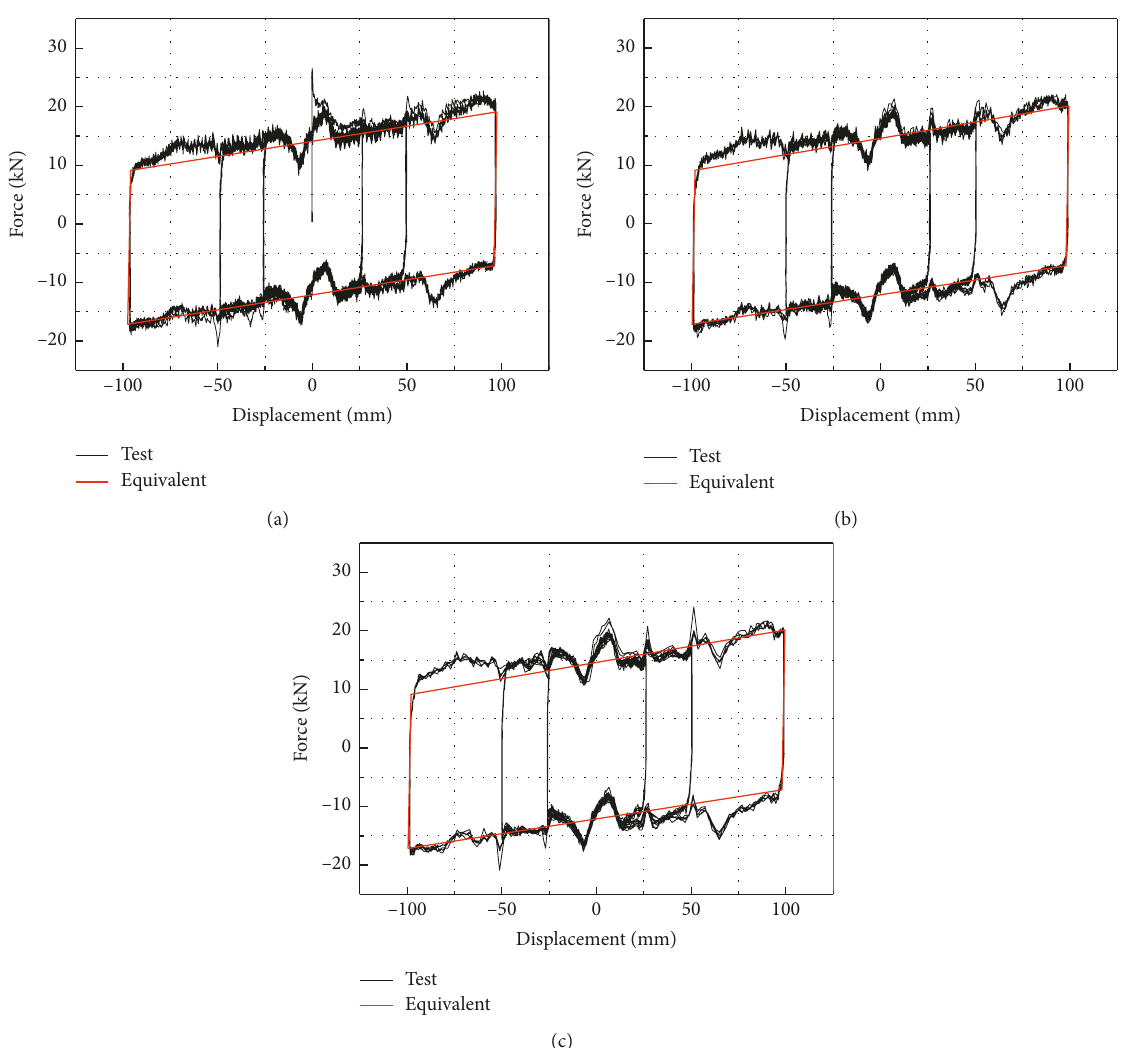
Figure 14: Friction test results of the bearing body. (a) 0.01. (b) 0.02. (c) 0.05Hz. Table 2: Mechanical parameters of the limited capacity bearing. Design parameters